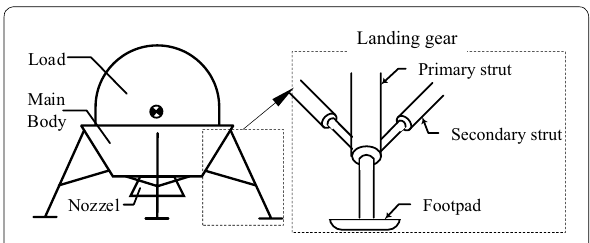
Figure 2 Main structures of the